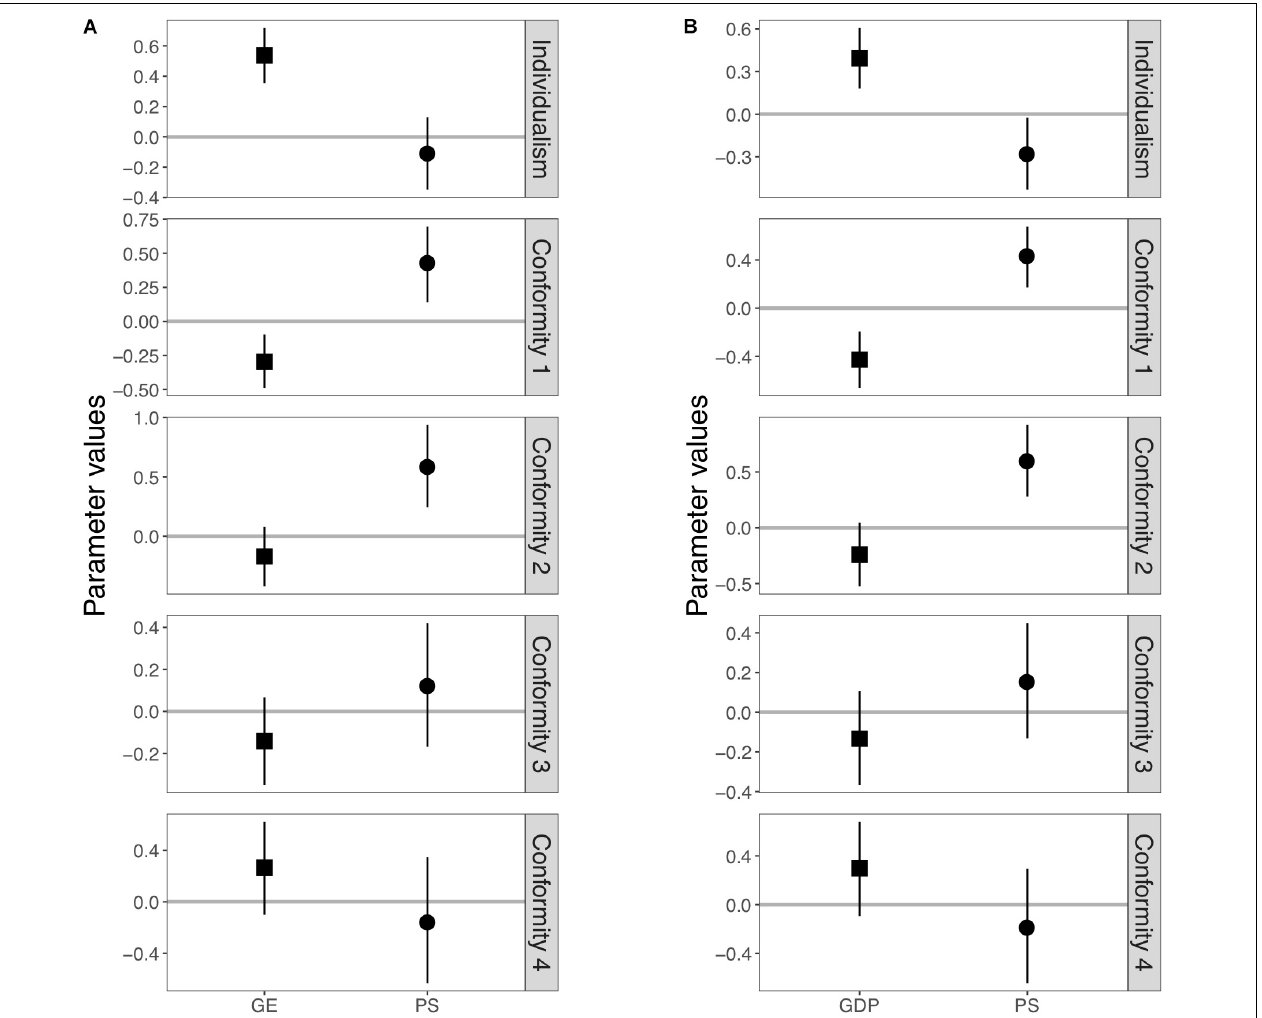
FIGURE 2 | Posterior distributions of the estimated values of slopes in Model 2. (A) Results using government effectiveness as an independent variable. (B) Results using GDP per capita as an independent variable instead of government effectiveness. Squares and circles represent posterior mean of slope affecting government effectiveness (or GDP per capita) and pathogen stress, respectively. Each error bar represents a 95% Bayesian credible